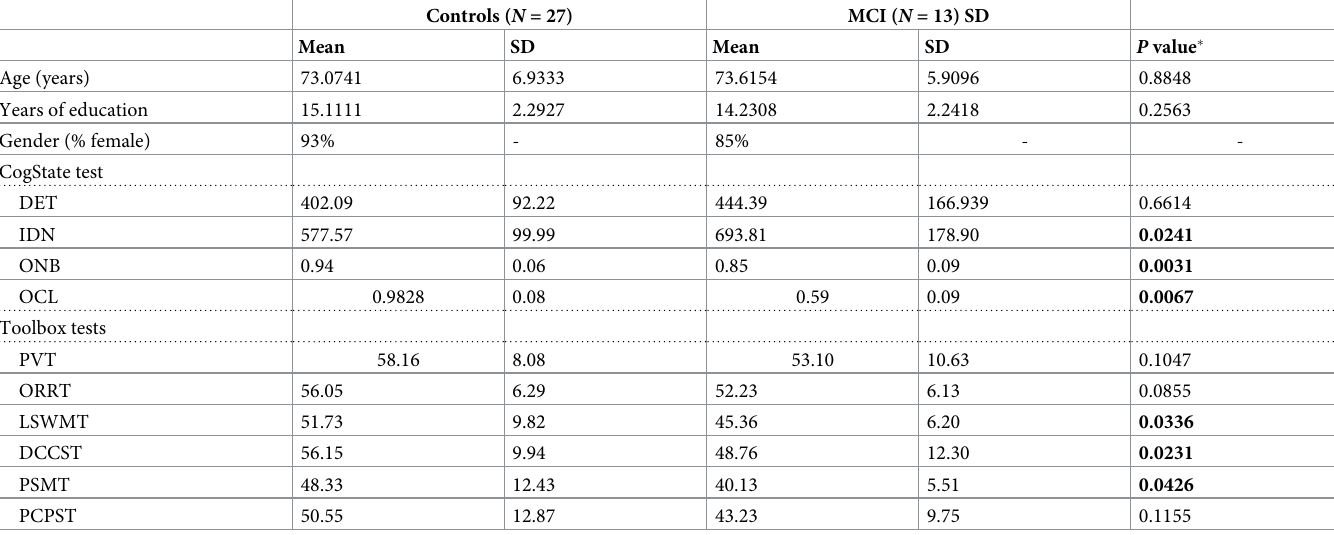
Table 2. Demographic characteristics and computerized neuropsychological tests of control and mild cognitive impairment subject groups.